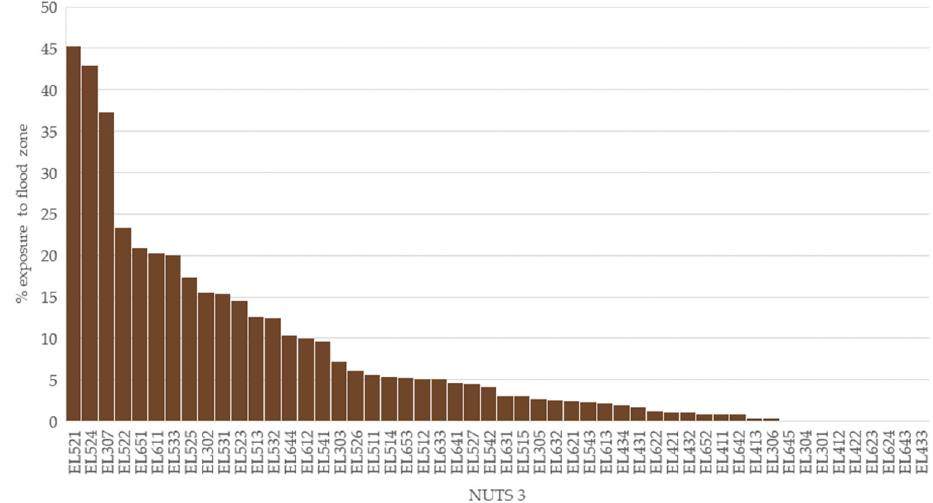
Figure 9. Graphical representation of the ratio of transportation infrastructure in flood zones per NUTS 3 in descending order.